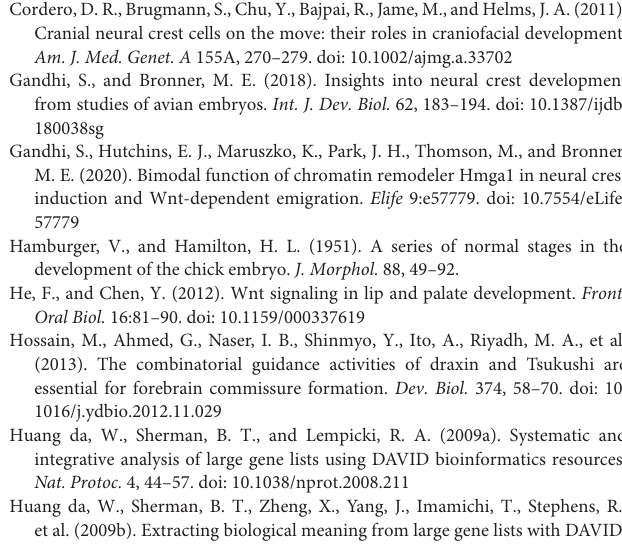
Supplementary Figure 1 | BMP-sensitive reporter expression is absent from delaminating and migratory cranial neural crest during EMT. (A) Schematic of cross section of cranial region at HH9 + examined in panel (B) . Locations of premigratory (pNC) and migratory crest cells (mNC) are indicated. (B) Following electroporation of a BMP fluorescent reporter construct (BRE:GFP), cross sections stained for a neural crest marker (Snail2, magenta) and membrane label